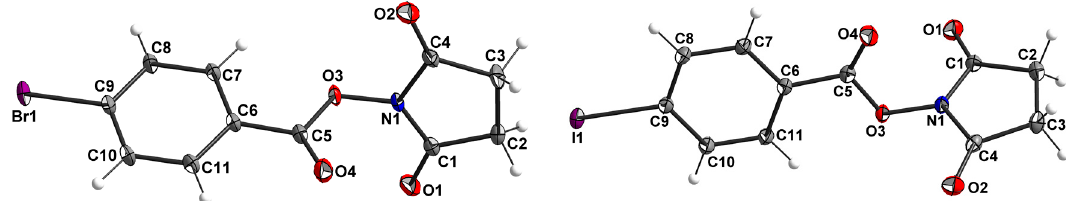
Figure 1. A view of the molecular structures of 3a ( left ) and 3b ( right ), showing the atom labeling scheme. Displacement ellipsoids are drawn at the 50% probability level.